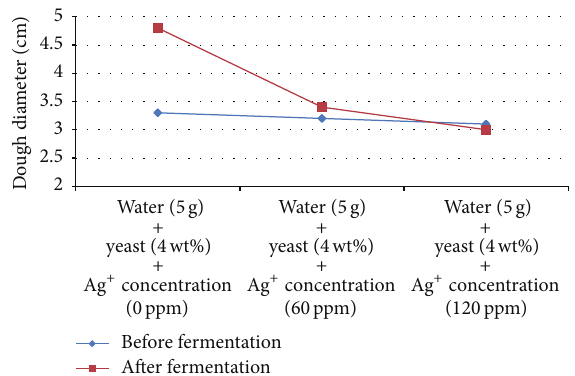
Figure 10: Experimental result of antibioactivity of Ag +